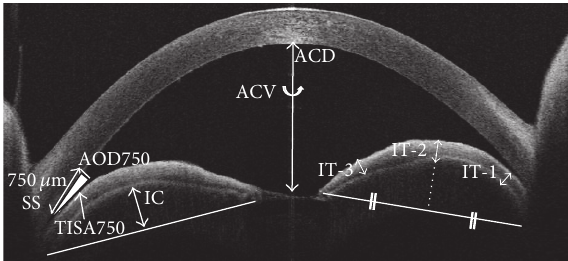
Figure 1: Anterior segment optical coherence tomography (AS-OCT) of iris bombe showing where the study variables were measured. SS: scleral spur.